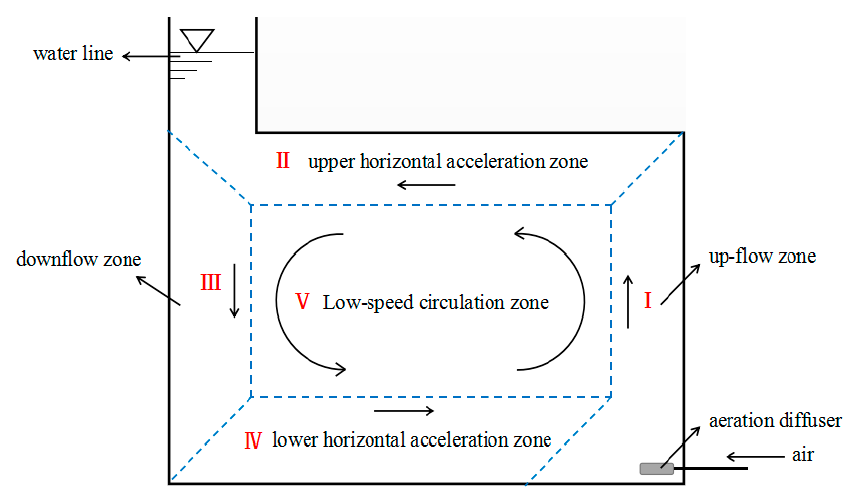
Figure 4. Schematic diagram of MPSR flow partition.